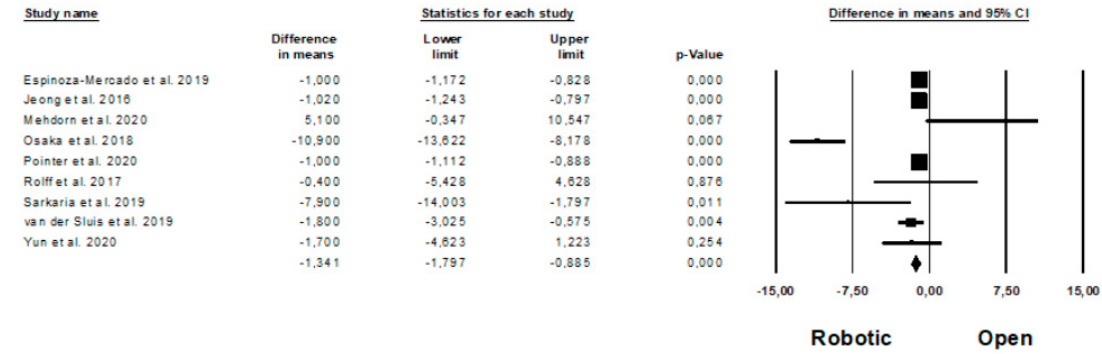
Figure 10. Robotic versus open surgery: length of hospital stay.